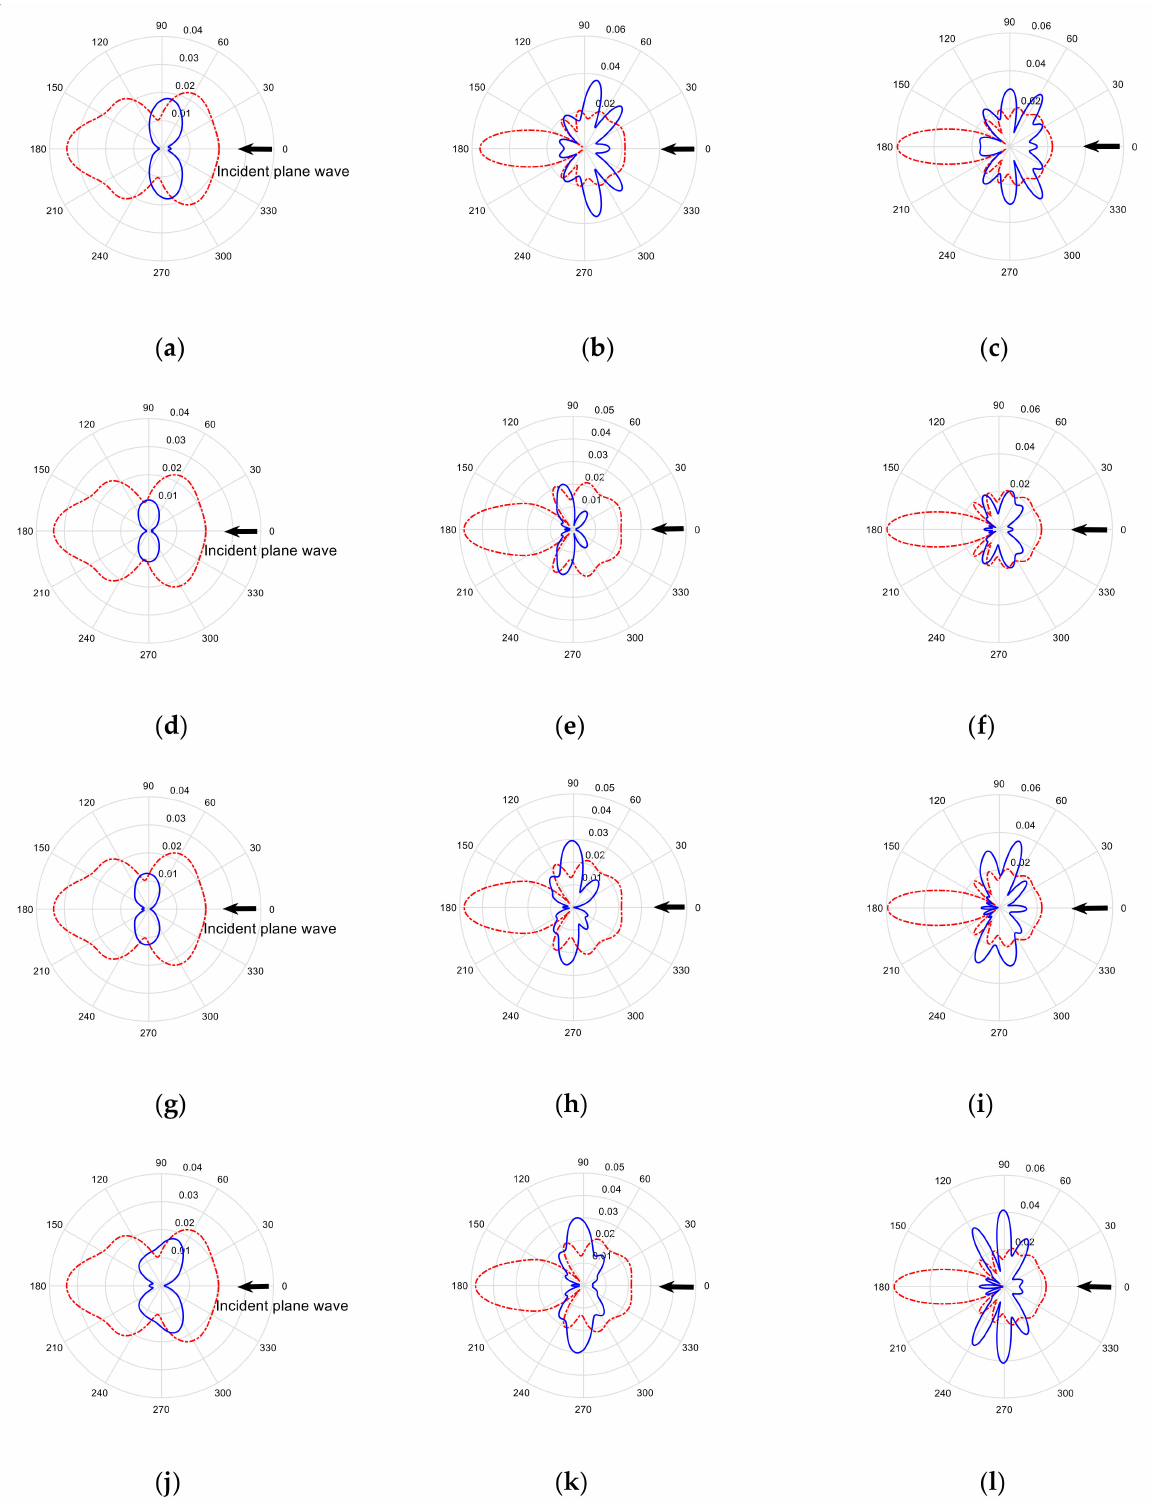
Figure 5. Comparison of the directivity for each method before and after active noise control at far-field observing points from 400 Hz to 1000 Hz: ( a ) Uni-RLS (400 Hz); ( b ) Uni-RLS (700 Hz); ( c ) Uni-RLS (1000 Hz); ( d ) CLASSO-RLS (400 Hz); ( e ) CLASSO-RLS (700 Hz); ( f ) CLASSO-RLS (1000 Hz); ( g ) LASSO-RLS- γ C (400 Hz); ( h ) LASSO-RLS- γ C (700 Hz); ( i ) LASSO-RLS- γ C (1000 Hz); ( j ) LASSO-RLS- γ NL (400 Hz); ( k ) LASSO-RLS- γ NL (700 Hz); and ( l ) LASSO-RLS- γ NL (1000 Hz). The red dotted line corresponds to the control off and the blue solid line corresponds to the control